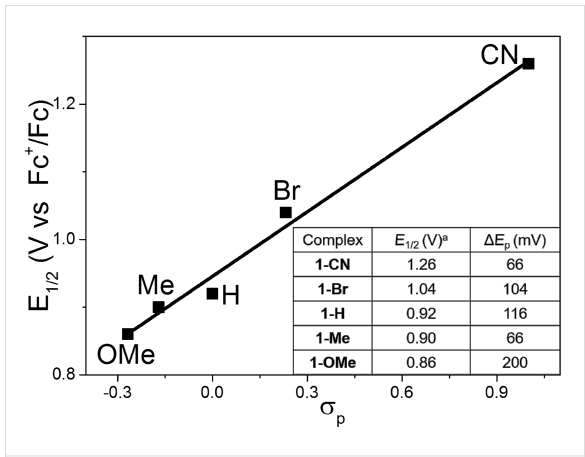
Figure 3: Correlation of Hammett constants σ p for the different ligands with midpoint potentials ( E 1/2 ) in complexes 1 -R. a CV data for 1 -R in MeCN/0.1 M TBAP vs Fc + /Fc under saturated Ar